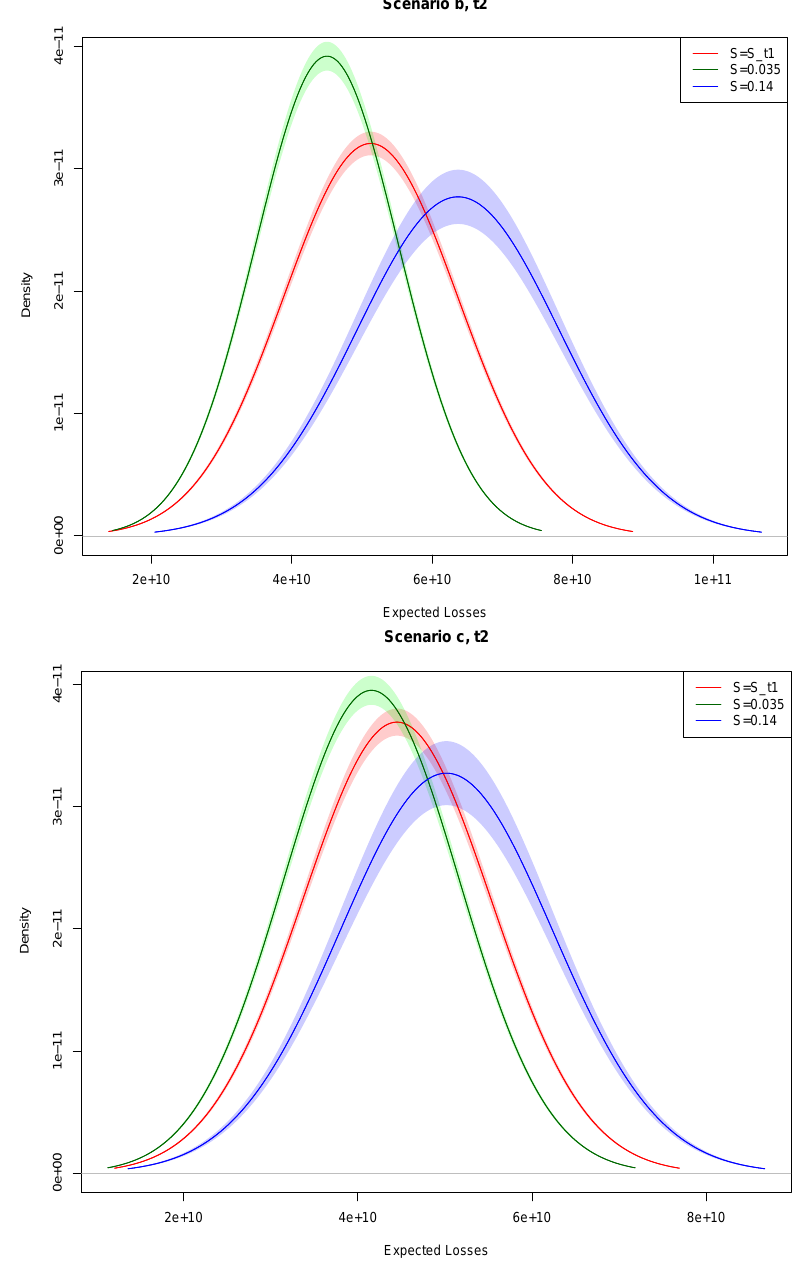
Figure 8. Total expected losses of the system when MPS is in trouble as a function of S MPS , t : private 2 intervention scenario and bail-in resolution. Notes: Monte Carlo simulated distributions of the expected losses of the entire banking system in case Monte dei Paschi di Siena is close to its default point, calculated at time t 2 as functions of S MPS , t in the context of a private intervention ( top ) or the bail-in 2 = S resolution ( bottom ). The red line represents the hypothesis S MPS , t MPS , t 1 ; the green line represents 2 = 0.5 · S = 2 · S the hypothesis S MPS , t MPS , t 1 ; the blue line represents the hypothesis S MPS , t 2 MPS , t 1 . 2 The bigger the default probability of MPS after the bail-in resolution, the bigger the expected losses for the entire banking system after the resolution action taken at time t 1